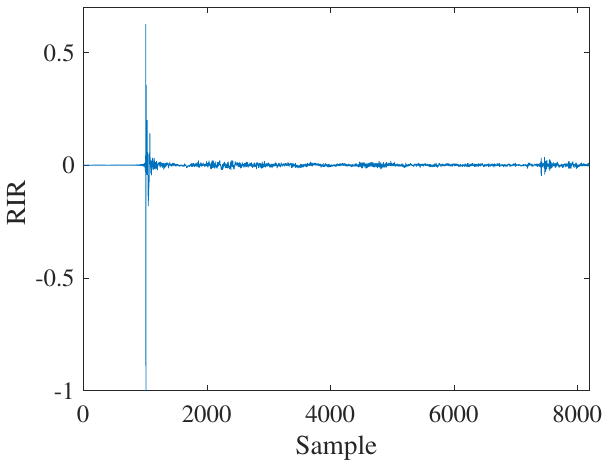
Figure 3. The auditorium room impulse response